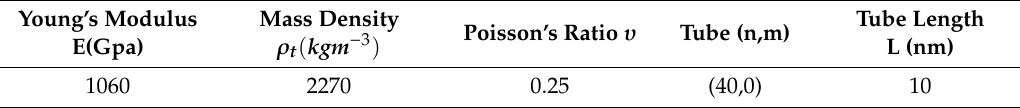
Table 1. Simulation parameters.